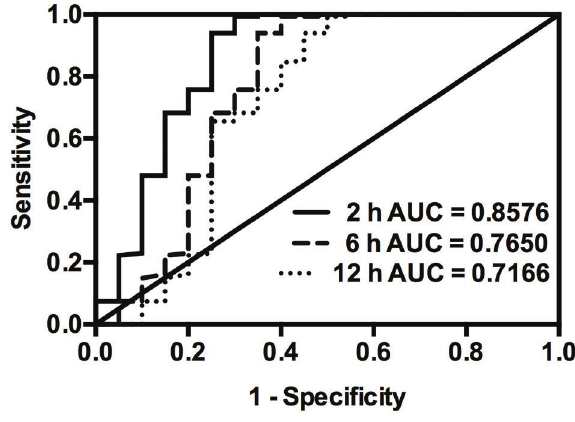
Figure 2. Receiver operating characteristics curves (AUC) of urinary semaphorin 3A at 2, 6, and 12 h post-percutaneous coronary intervention.